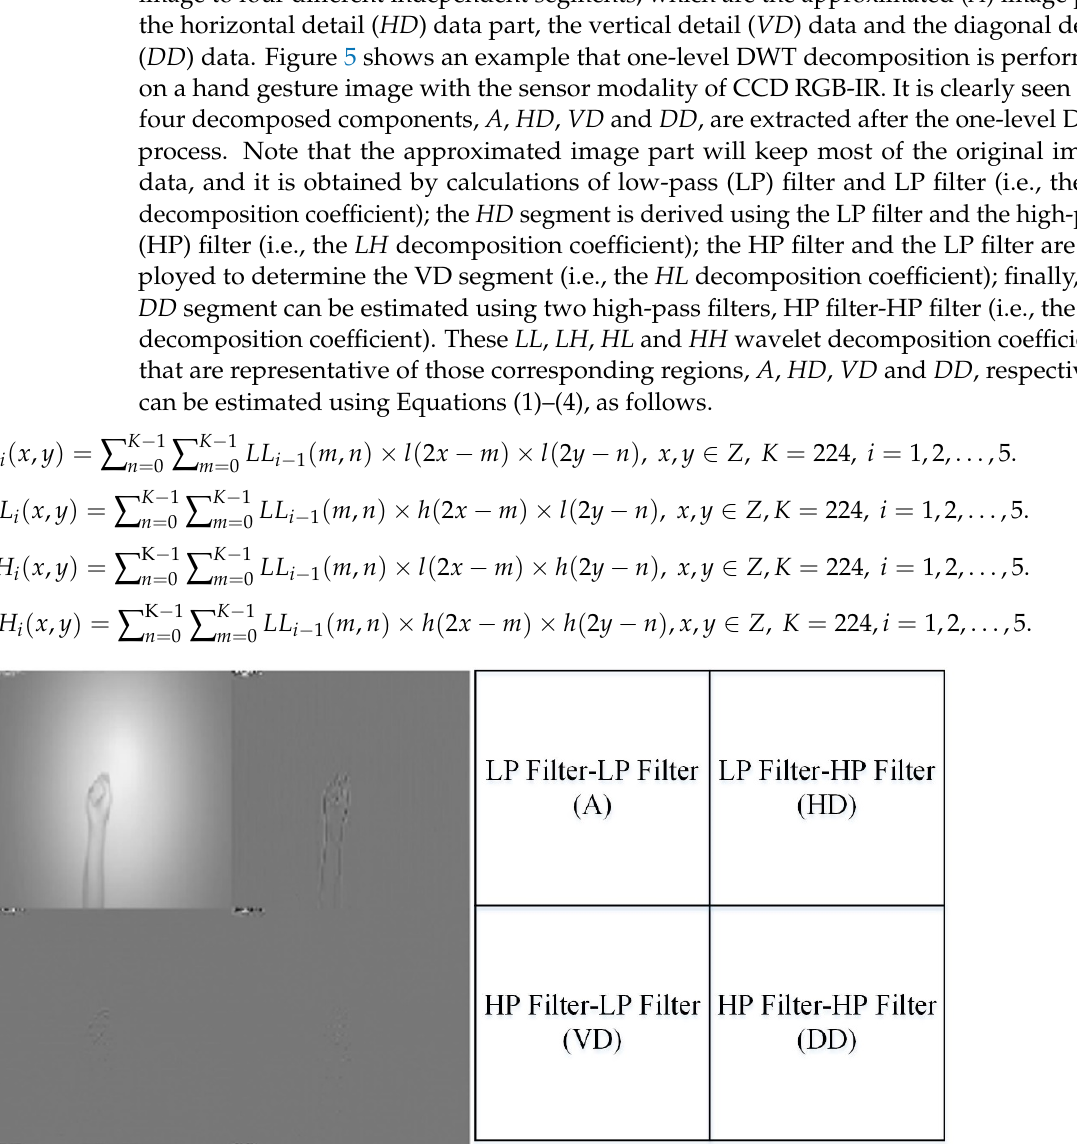
Figure 5. Four separated decomposition components, image data of the approximate ( A ), detailed data of the horizontal ( H ), detailed data of the vertical ( V ) and detailed data of the diagonal ( D ), derived from discrete wavelet transform (one-level DWT decomposition on CCD RGB-IR, for ex- ample).